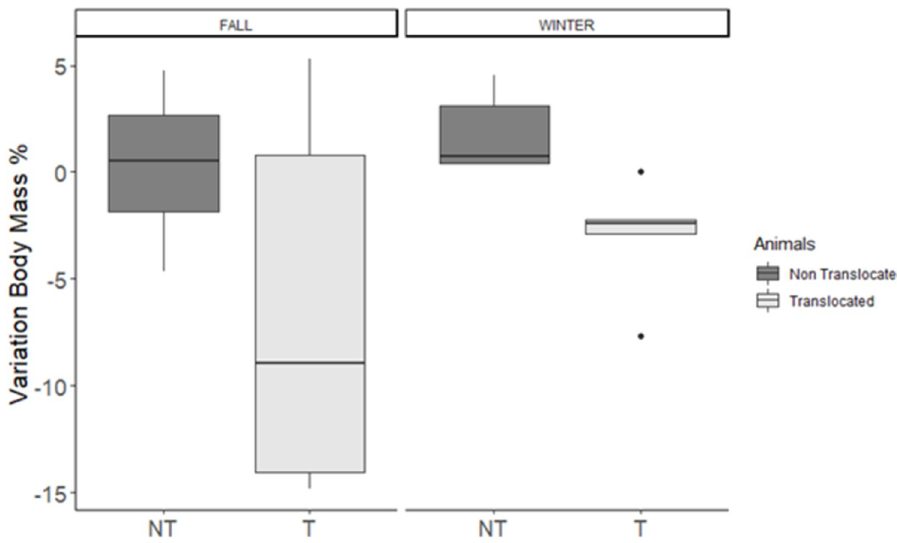
Fig 3. The variation in body mass of translocated red squirrels Tamiasciurus fremonti fremonti (N = 10), expressed as percentage of body mass change after translocation in respect to the weight at release. In dark color the variation in body mass of non-translocated animals (N = 9), expressed as percentage of body mass change between two trapping sections in respect to the weight of the first trapping event (as a control group).